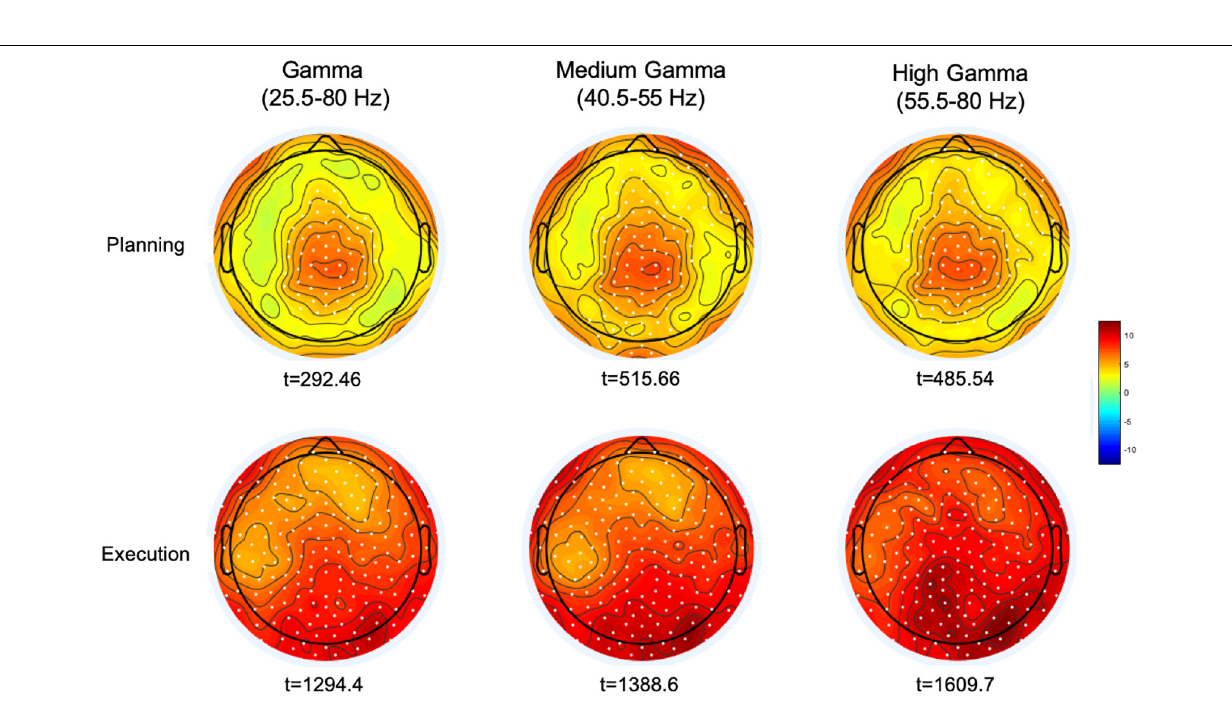
FIGURE 3 | Maps of the cluster-corrected permutation-based t-values comparing gamma oscillatory activity with the average spectral power during the planning (–152 to –52 ms) and execution time-windows (52–500 ms). Significant electrodes are reported as white dots ( p < 0.0005). The color bar represents the magnitude of the t